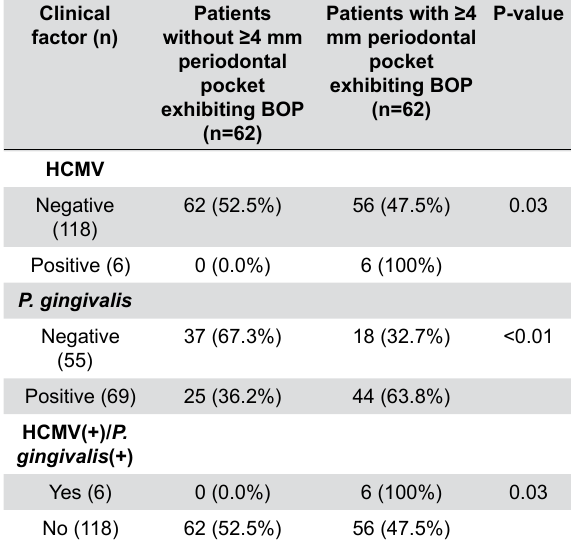
with HCMV and P. gingivalis in 124 propensity score-matched